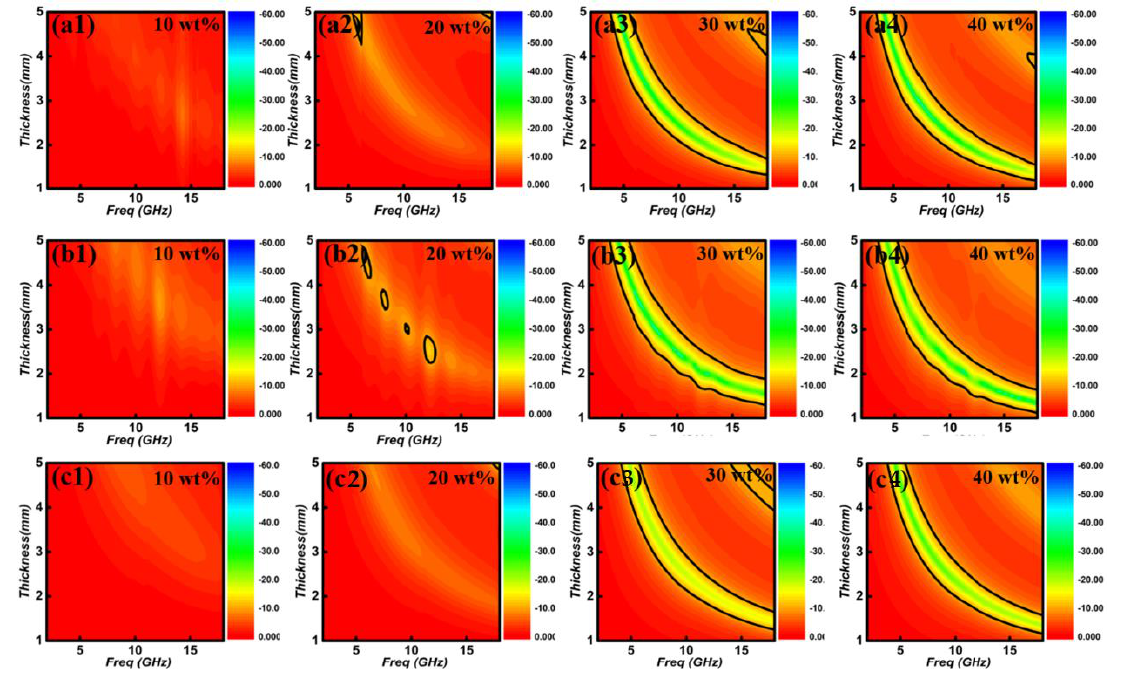
Figure 7. 3D RL maps of Fe 3 O 4 ( a1 – a4 ), CoFe 2 O 4 ( b1 – b4 , c1 – c4 ) NiFe 2 O 4 /paraffin wax composites with different thickness in the frequency range of 2~18.0 GHz.